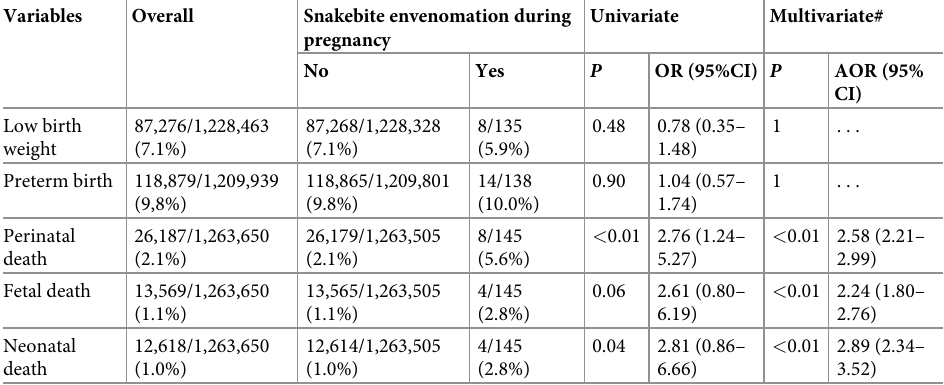
Table 4. Perinatal outcomes in pregnant women affected by snakebite envenomation and other pregnant women.